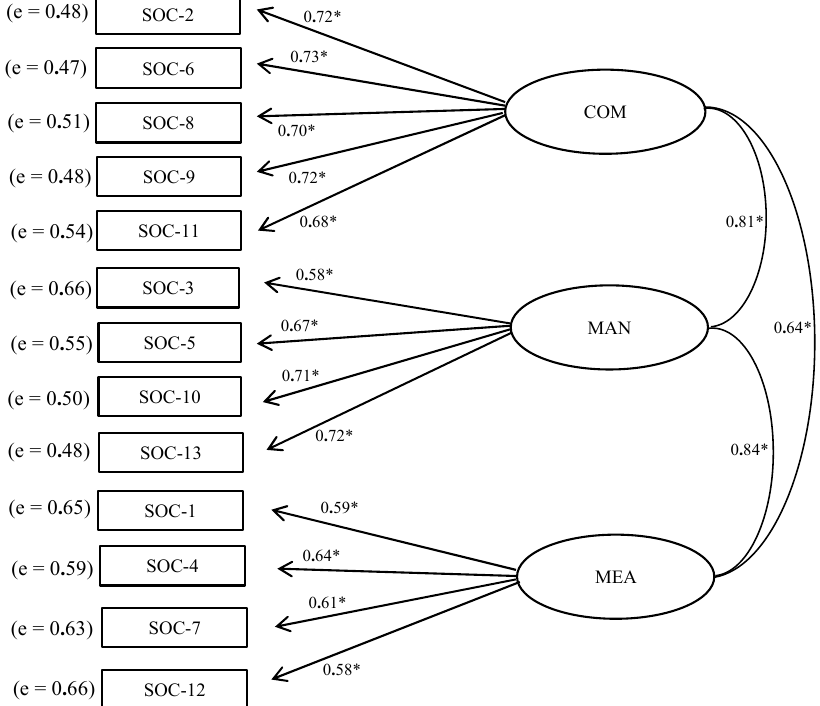
Figure 1. Path diagram of Confirmatory Factor Analysis for the SOC-13 scale Colombian version. COM = comprehensibility, MAN = manageability, MEA = meaningfulness. (* p < 0.05).